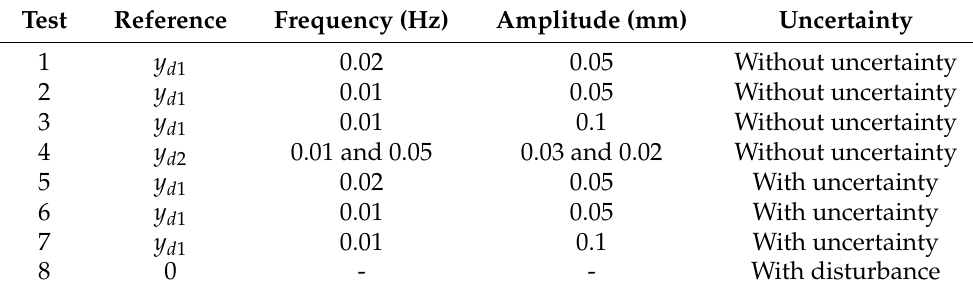
Table 1. Configurations of the experimental